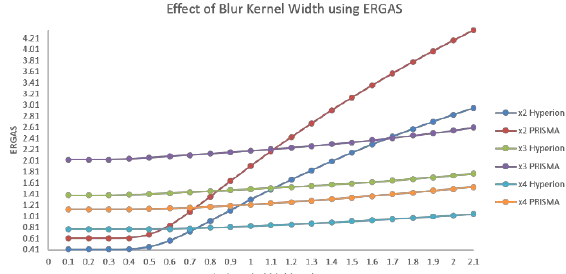
Figure 6. Effect of Blur Kernel Width Using ERGAS on IBP’s Performance